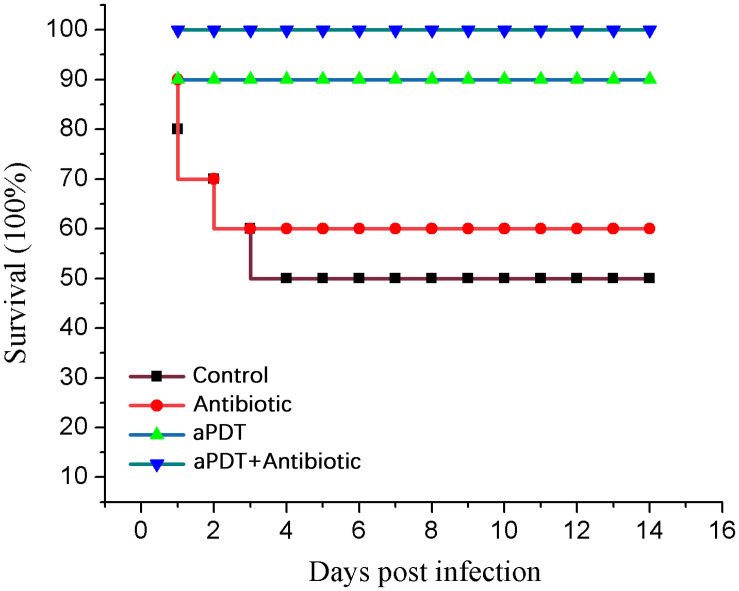
Survival of treated and untreated rats.